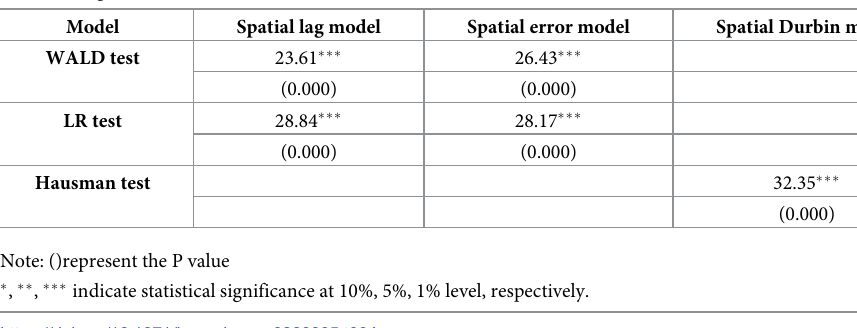
Table 4. Regression results of different tests.